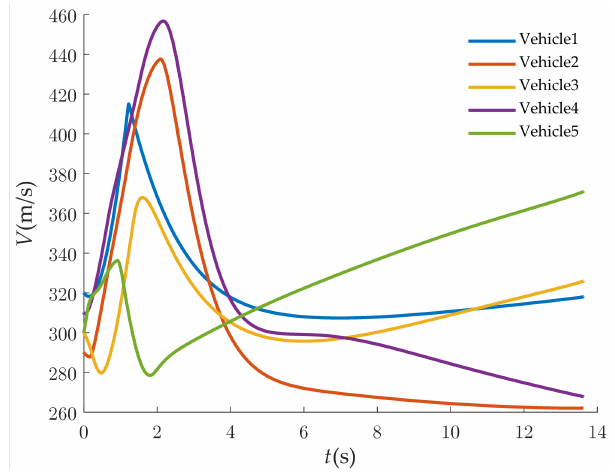
Figure 9. Velocities of multiple vehicles.